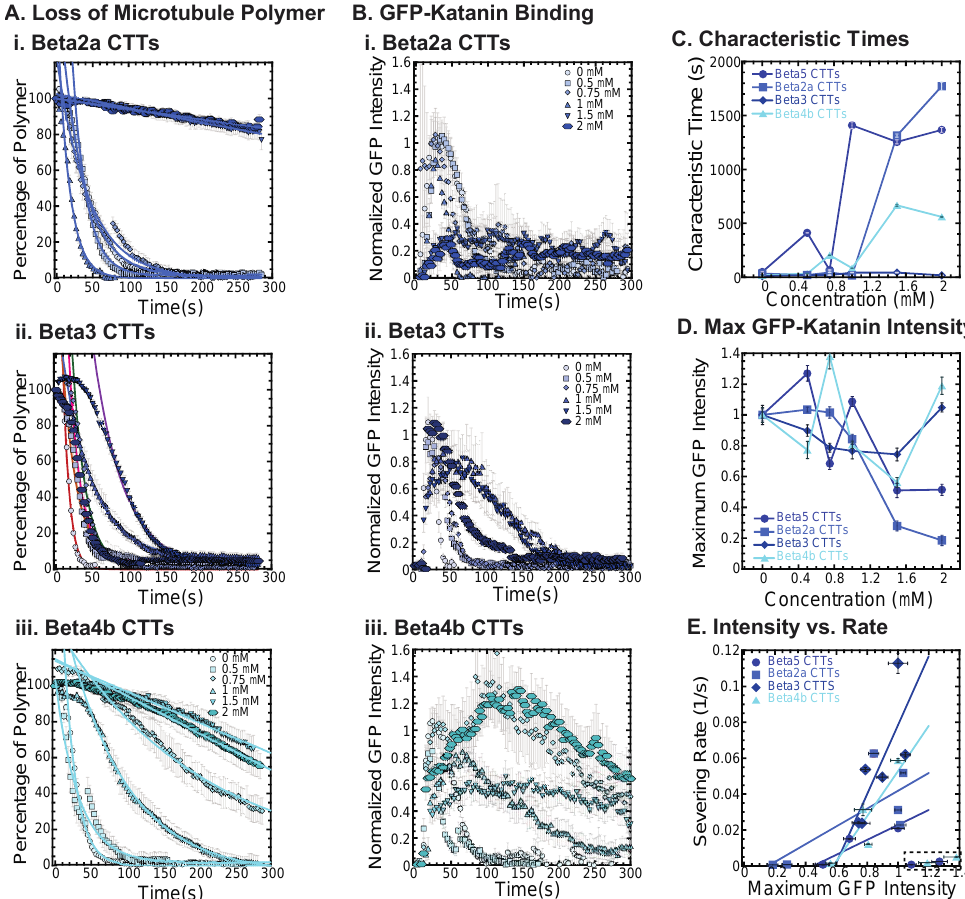
Figure 4 . Effects of beta tubulin isotype sequence on katanin inhibition. ( A ) Loss of polymer caused by increasing concentration of ( i ) beta2a CTTs (light blue), ( ii ) beta3 CTTs (navy blue), and ( iii ) beta4b CTTs (cyan). The transition from exponential decay to linear decay is observed for loss of polymer data as it goes from no inhibitor (0 μM, lightest shade circles), low inhibitor (0.5 μM, light shade squares; 0.75 μM, light shade diamonds), medium inhibitor (1 μM, medium shade triangles with point up), to highest inhibitor (1.5 μM, darker shade triangles with point down, 2 μM, darkest shade hexagons). Each dataset is fit with a best fit equation to an exponential or linear decay with best fit parameters provided in Supplemental Information Table S6. ( B ) The data for the GFP- katanin binding by increasing concentration of ( i ) beta2a CTTs (light blue), ( ii ) beta3 CTTs (navy blue), and ( iii ) beta4b CTTs (cyan). The data were normalized by the maximum when there was no inhibitor (0 μM, lightest shade circles). Data for low inhibitor (0.5 μM, light shade squares; 0.75 μM, light shade diamonds), medium inhibitor (1 μM, medium shade triangles with point up), to highest inhibitor (1.5 μM, darker shade triangles with point down, 2 μM, darkest shade hexagons) are shown. ( C ) The characteristic decay times for loss of polymer as a function of concentration for beta CTTs (bright blue circles), beta2a CTTs (light blue squares), beta3 CTTs (navy blue diamonds), and beta4b CTTs (cyan triangles). Error bars represent the uncertainty in the fit parameters. ( D ) The average normalized maximum for GFP-katanin binding to microtubules for beta CTTs (bright blue circles), beta2a CTTs (light blue squares), beta3 CTTs (navy blue diamonds), and beta4b CTTs (cyan triangles). Error bars represent the standard deviation of the average. ( E ) Plotting the rate of micro- tubule severing as a function of average normalized maximum intensity for beta CTTs (bright blue circles), beta2a CTTs (light blue squares), beta3 CTTs (navy blue diamonds), and beta4b CTTs (cyan triangles). Data with high GFP-katanin intensity due to a slow accumulation with little loss of pol- ymer denoted by dashed line box (lower right). Removing these data, we fit the severing rate to a linear fit as a function of GFP-katanin. Representative movies in Supplemental Information Movies S7 – S9.